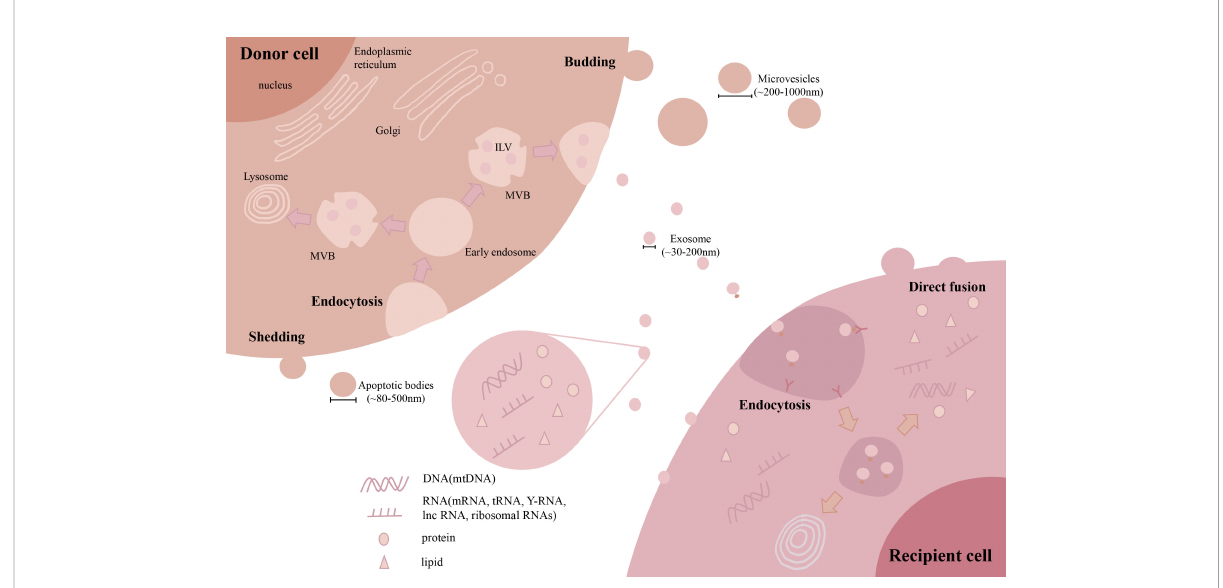
FIGURE 3 Biogenesis and uptake of EVs. During exosome biogenesis, the plasma membrane is endocytosed to form early endosomes and then matures into MVBs. The delimiting membrane of MVBs invaginates from the ILVs. Finally, some MVBs bind to the cell membrane to release ILVs. MVs are mainly originated by outward budding at the cell plasma membrane. For cellular uptake, EVs can be taken up by recipient cells via direct membrane fusion or endocytosis by interacting with receptors on the surface. (Extracellular vesicles: EVs, microvesicles: MVs, multivesicular body: MVB, intraluminal vesicles: ILV, microRNA: miRNAs, long noncoding RNA: lncRNA, mitochondrial DNA: